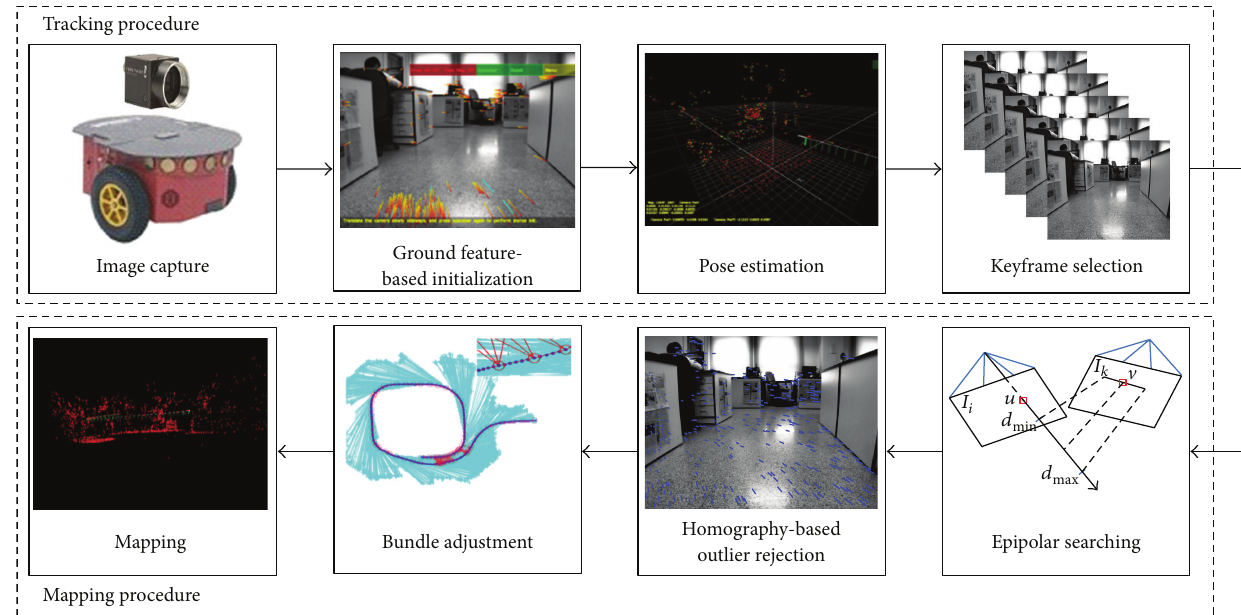
Figure 1: The illustration of the proposed